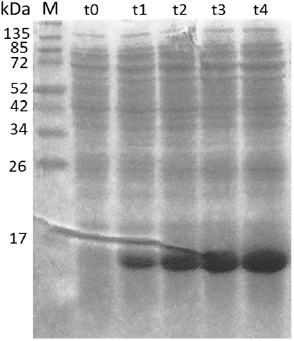
Figure 2. SDS page of the time course of the expression of ORF3 (13.6 kDa) recombinant protein. The expression was evaluated at different time points (t) corresponding to hours post-induction. M: molecular weight marker.